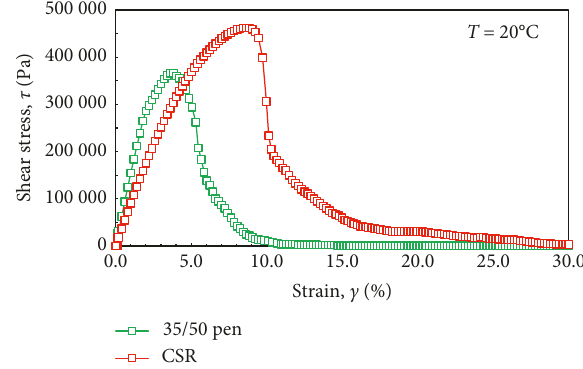
Figure 22: LAS test results ( τ vs. c )—35/50 pen vs. CSR shear stress evolution.